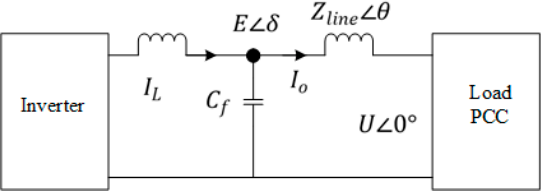
Figure 1. The topology of the three-level inverter.